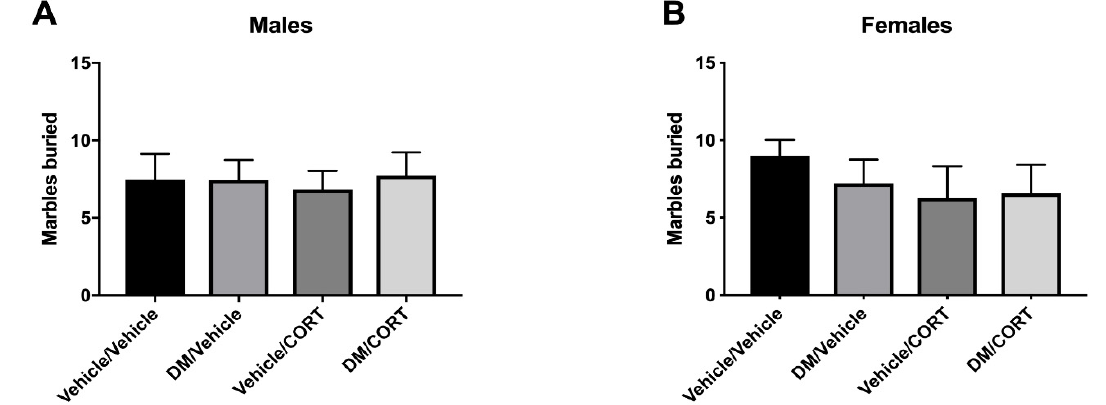
Figure 8. There was no significant difference in impulsivity, as measured by marble burying, in male ( A ) and female ( B ) offspring exposed to one of four treatment groups. Twenty marbles were placed in a 4 × 5 pattern on top of clean bedding. Offspring were tested at 8 weeks of age and allowed to roam freely for 30 minutes total. The number of marbles buried at least 50%, as scored by two independent scorers, is reported. N = 7–9, differences between exposure groups were assessed via one ‐ way ANOVA with Tukey’s post ‐ hoc analyses and were stratified by sex. Alpha level of 0.05 was used and error bars represent SEM.